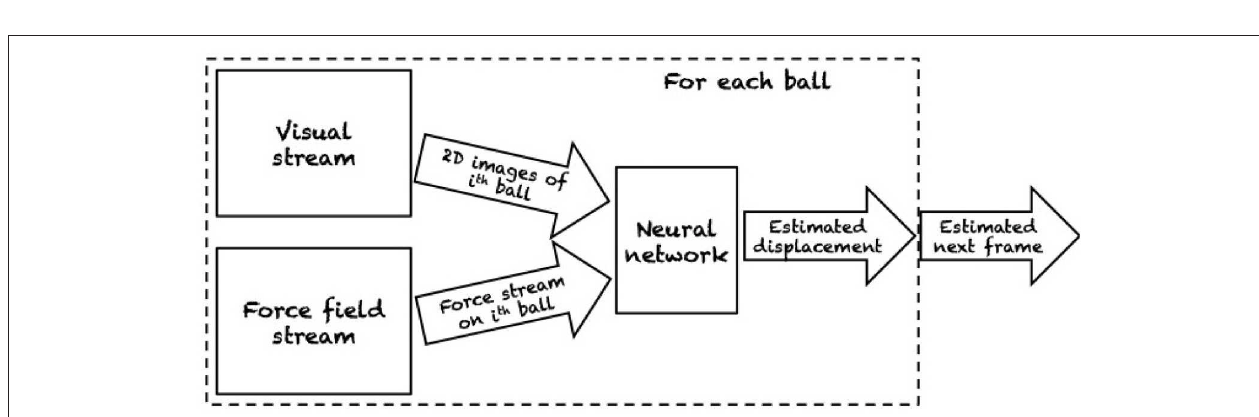
FIGURE 10 | Frame-centric model for motion prediction of billiard balls. The model takes as input the 2D image of the billiard and the forces applied by the agent to make predictions about the future configurations of the balls. Reproduced from Fragkiadaki et al. (2015).